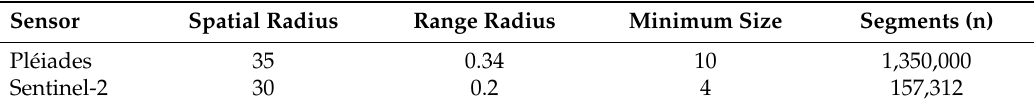
Table 4. Sensor-specific parameters used for creating the segmentation: Range Radius (RR), Spatial Radius (SR) and Minimum Size (MS). The resulting number of created segments is also indicated.